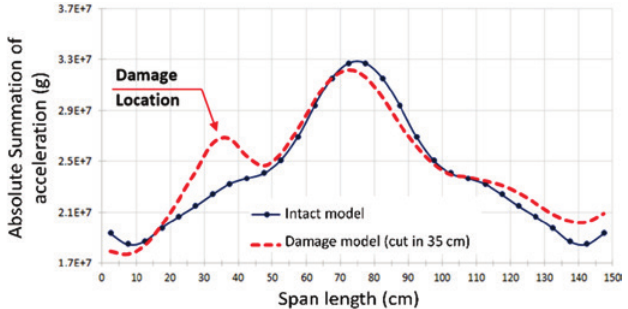
Comparison of the absolute sum of the accelerations obtained from the model with only one